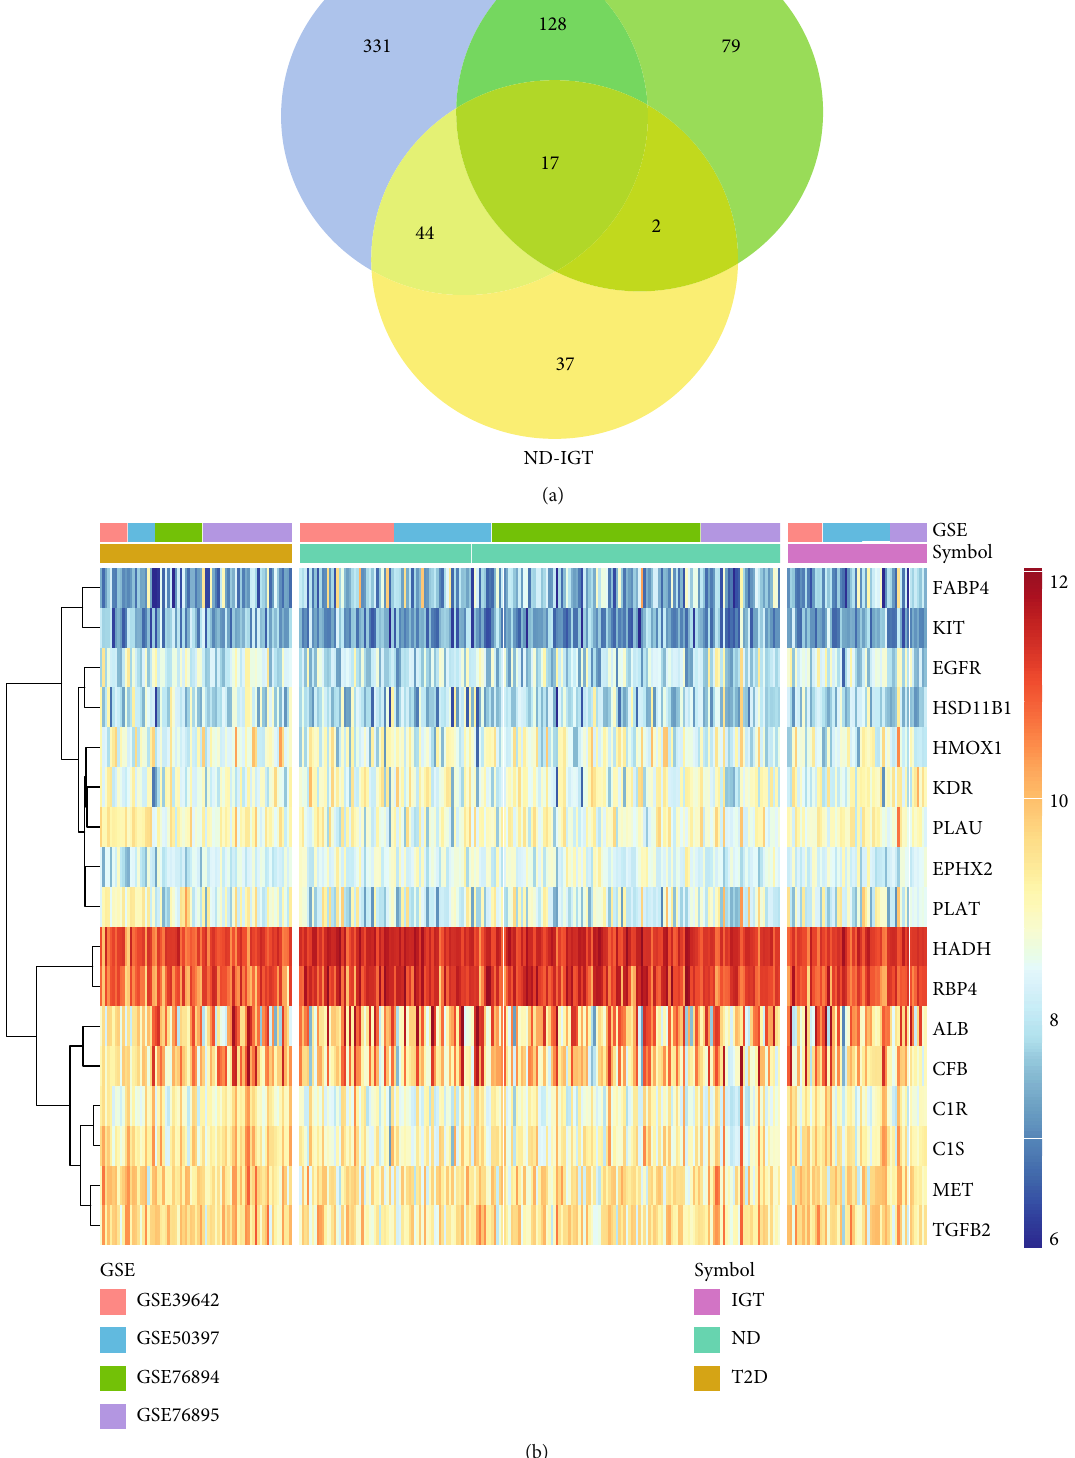
Figure 3: Venn diagrams and heatmaps of intersecting genes in ND-IGT-T2D. (a) Venn plots showing common upregulated and downregulated DEGs shared by ND-IGT, IGT-T2D, and ND-T2D. (b) The expression level of common up and downregulated DEGs in ND, IGT, and